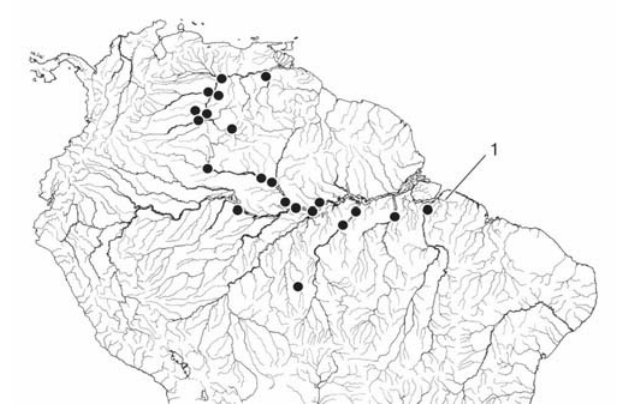
Fig. 7. Map of central and northern South America showing distribution of Auchenipterichthys longimanus (1 = holo- type locality; some symbols represent more than one locality or lot